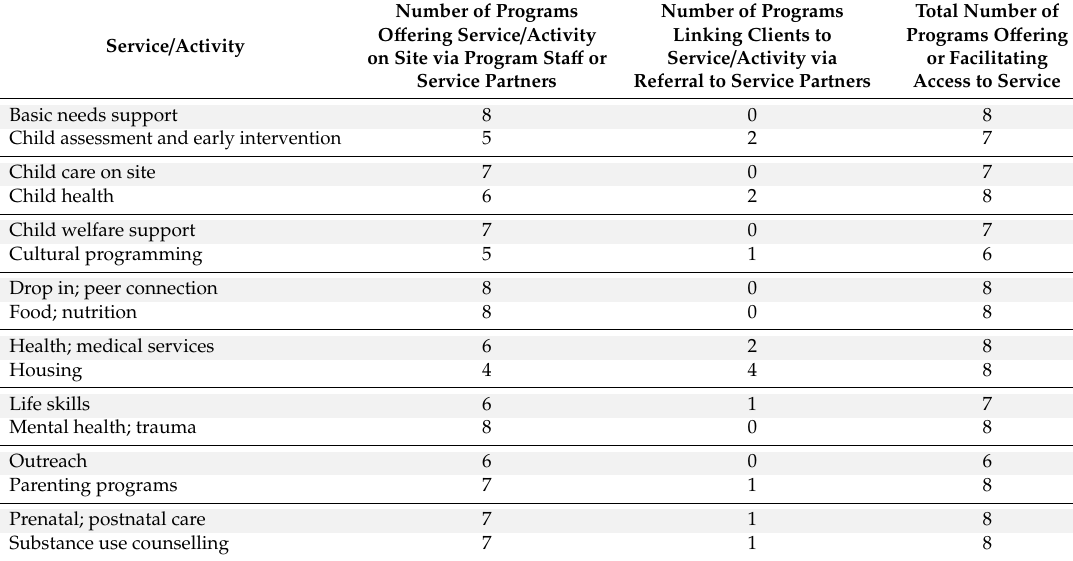
Table 1. Services/activities offered by programs via staff or service partners or via referrals. Table 1. Services / activities o ff ered by programs via sta ff or service partners or via